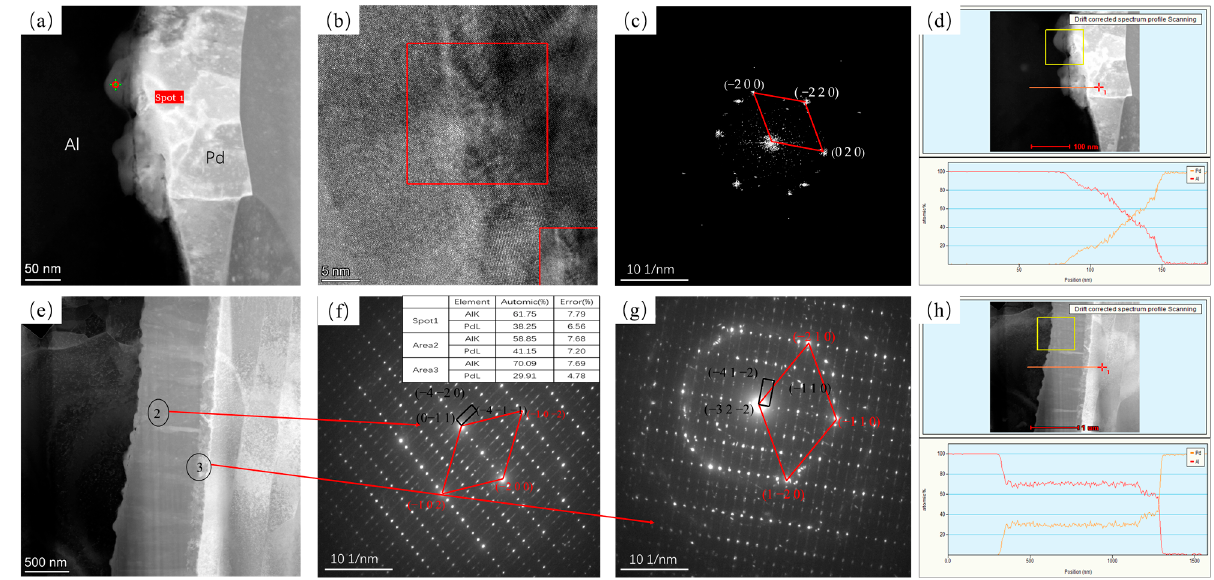
Figure 5. TEM plots of Pd/Al composite wires annealed at 250 °C for different times and their SEAD plots: ( a ) HAADF plot at 5 s, ( b ) high-resolution plot of spot 1 in ( a , c ) FFT transform of the red region in ( b , d ) EDS line sweep at 5 s, ( e ) HAADF plot at 1080 s, ( f ) SAED plot of spot 2 in ( e , g ) SAED plot of spot 3 in ( e ) and EDS results for each position, and ( h ) EDS line sweep at 10,800 s.